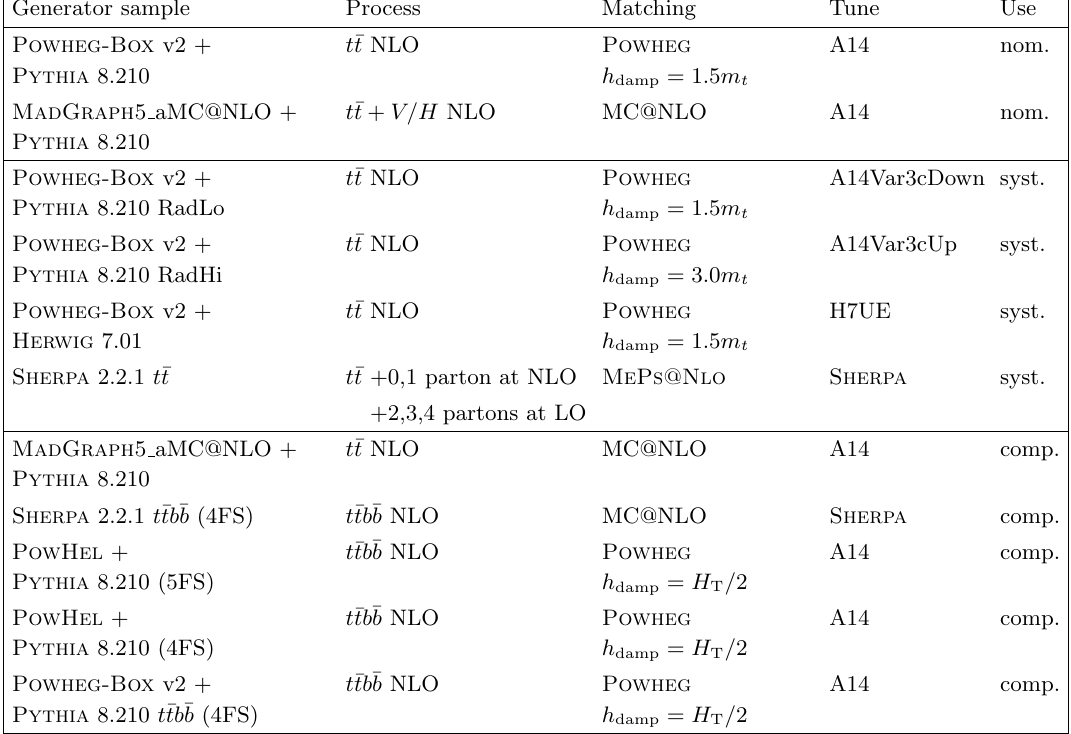
Table 1. Summary of the MC sample set-ups used for modelling the signal processes ( t (cid:22) t + t (cid:22) tV + t (cid:22) tH ) for the data analysis and for comparisons with the measured cross-sections and di(cid:11)erential distributions. All samples used the NNPDF3.0NLO PDF set with the exception of the two Sherpa samples, which used NNPDF3.0NNLO. The di(cid:11)erent blocks indicate from top to bottom the samples used as nominal MC (nom.), systematic variations (syst.) and for comparison only (comp.). For details see section